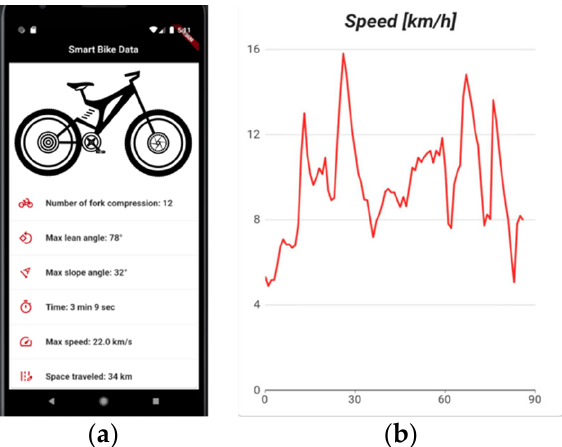
Figure 13. The smart bike app: ( a ) the bike data; ( b ) speed evolution during the tour.